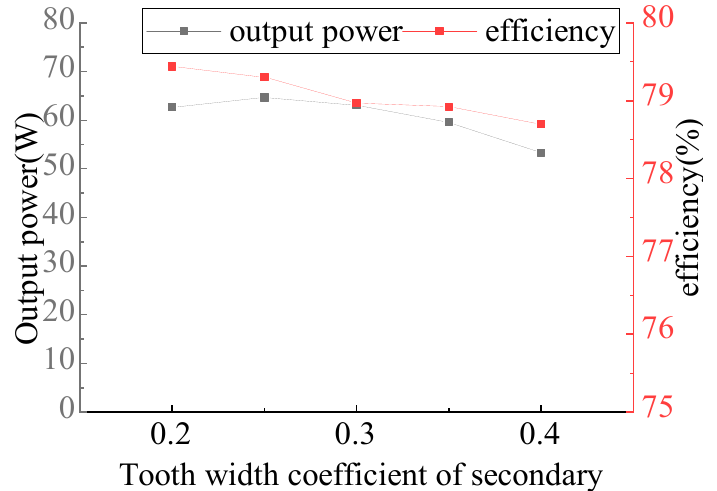
Figure 12. Relationships between output power and efficiency with the tooth width coefficient of the secondary tooth.